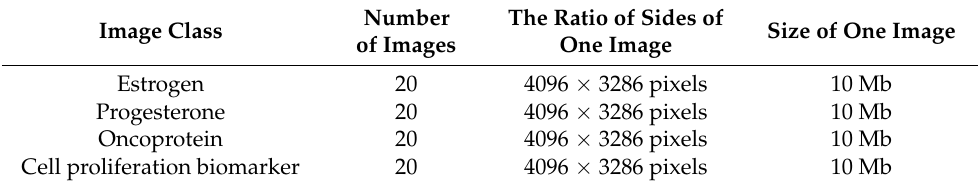
Table 1. Characteristics of an immunohistochemical image